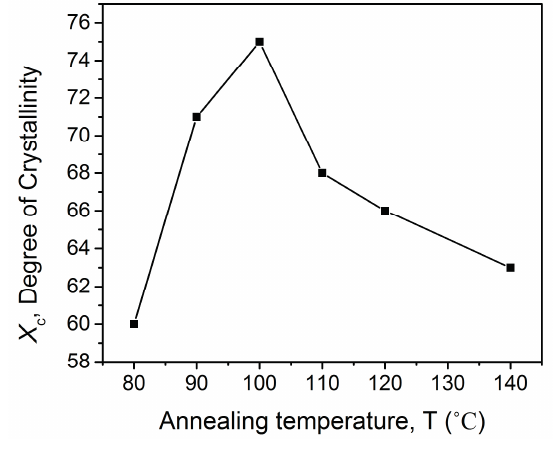
Figure 2. Dependence of the degree of the crystalline structure as a function of annealing